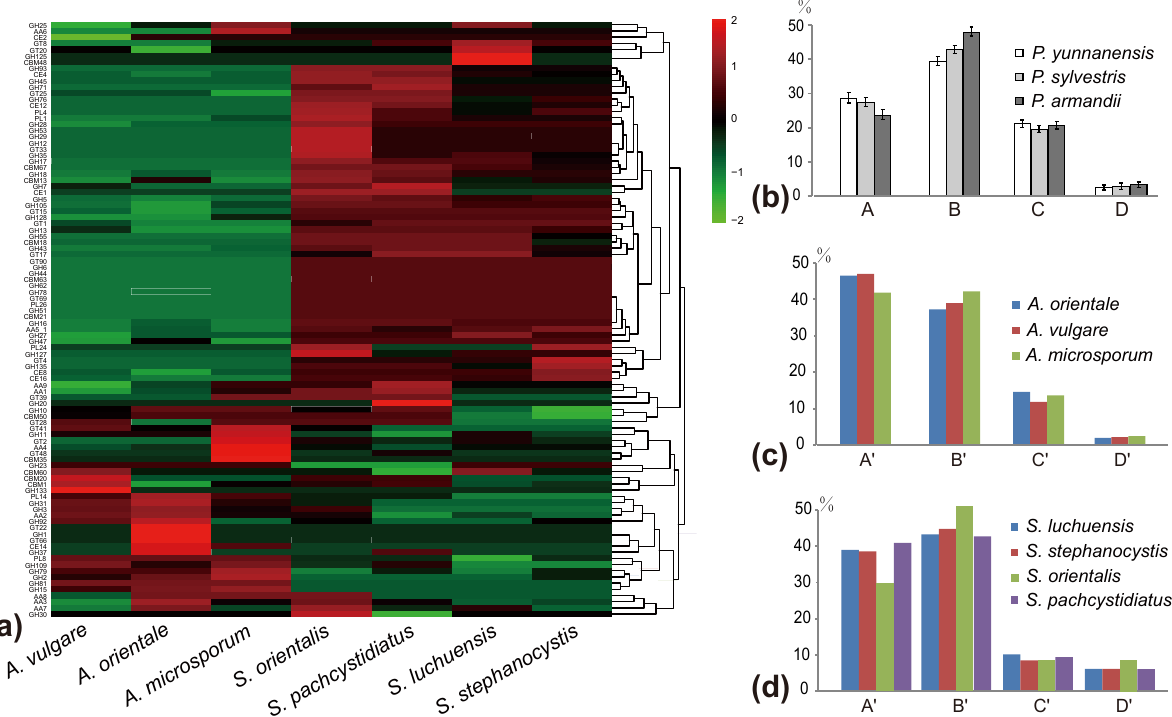
Figure 3. Comparisons of the carbohydrate-active enzymes (CAZymes) in Auriscalpium and Strobilurus , the proportions of four major chemical components in different cones, and the proportions of different enzymes encoded by lignocellulolytic genes in the two fungi groups. ( a ) Heatmap analysis of seven fungi in Auriscalpium and Strobilurus of CAZymes. ( b ) Four components of three different newly fallen cones. A, B, C and D in x -axis represent lignin, cellulose, hemicellulose and pectin, respectively. The y -axis represents the proportion of the four components. ( c ) The proportions of lignocellulolytic genes in different fungi of Auriscalpium . A’, B’, C’, D’ in x -axis represent ligninase, cellulose, hemicellulose, pectinase, respectively. The y -axis represents the proportion of the four types of enzymes; the same below. ( d ) The proportions of lignocellulolytic genes in different fungi of Strobilurus